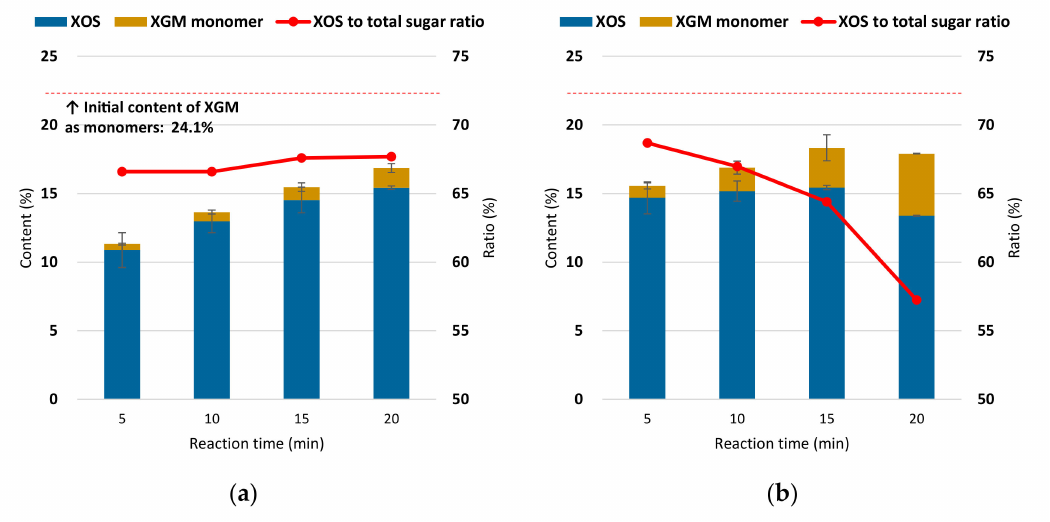
Figure 2. XGM content and XOS to total sugar ratio with reaction time change: ( a ) 180 ◦ C; ( b ) 190 ◦ C.